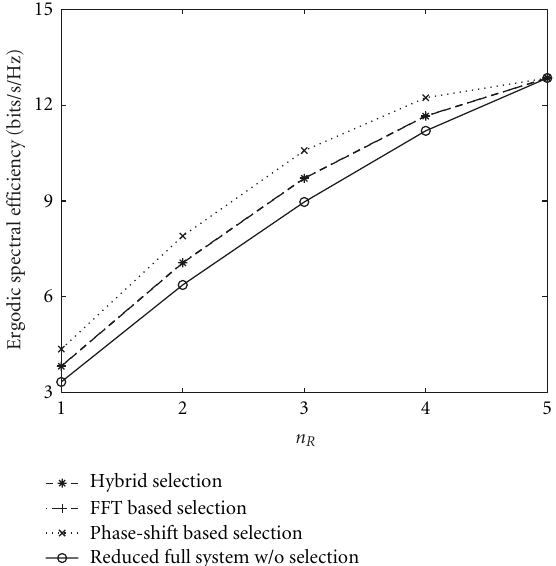
Figure 5: Ergodic spectral e ffi ciency of a compact MIMO system ( M = 5) with mutual coupling at both transmitter and receiver sides.